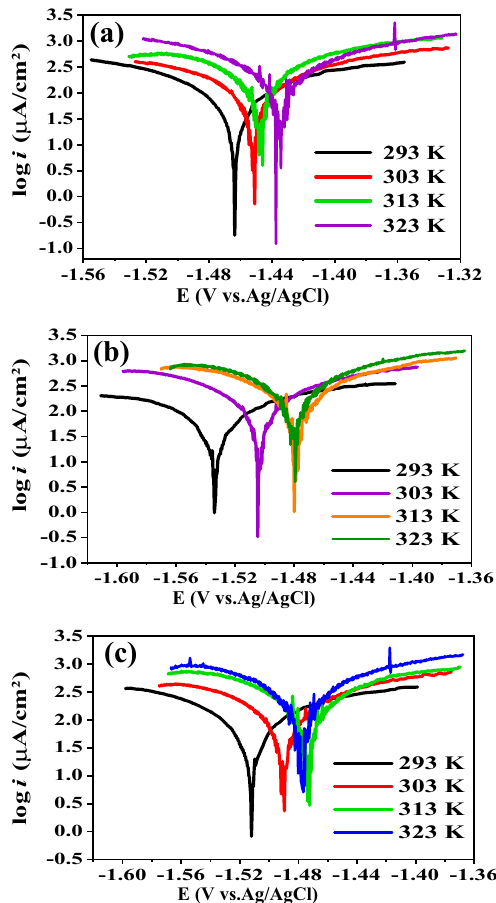
Figure 6. PDP curves of Al in 0.1 M NaOH solution in the absence and presence of 300 ppm of Cefx and Cefz drugs at different temperatures: ( a ) blank, ( b ) Cefx and ( c )